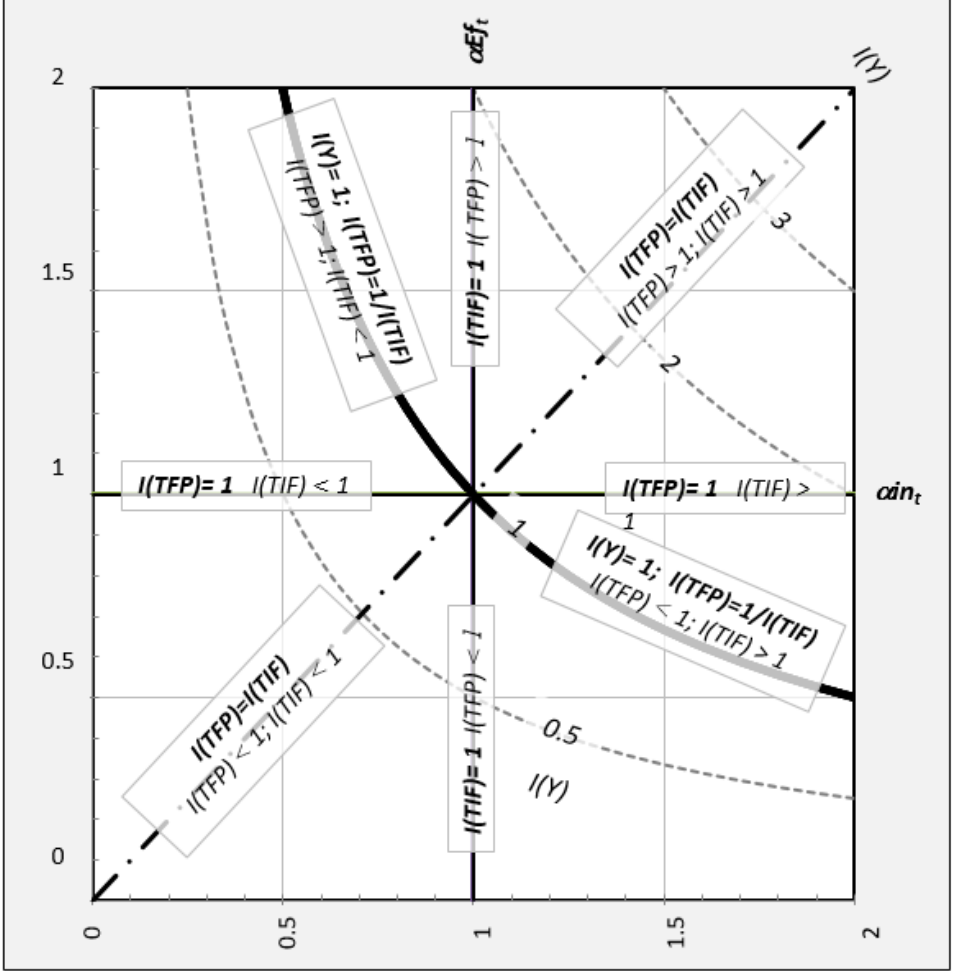
Figure 2. Detailed description of pure and combined types of all possible developments of a system.